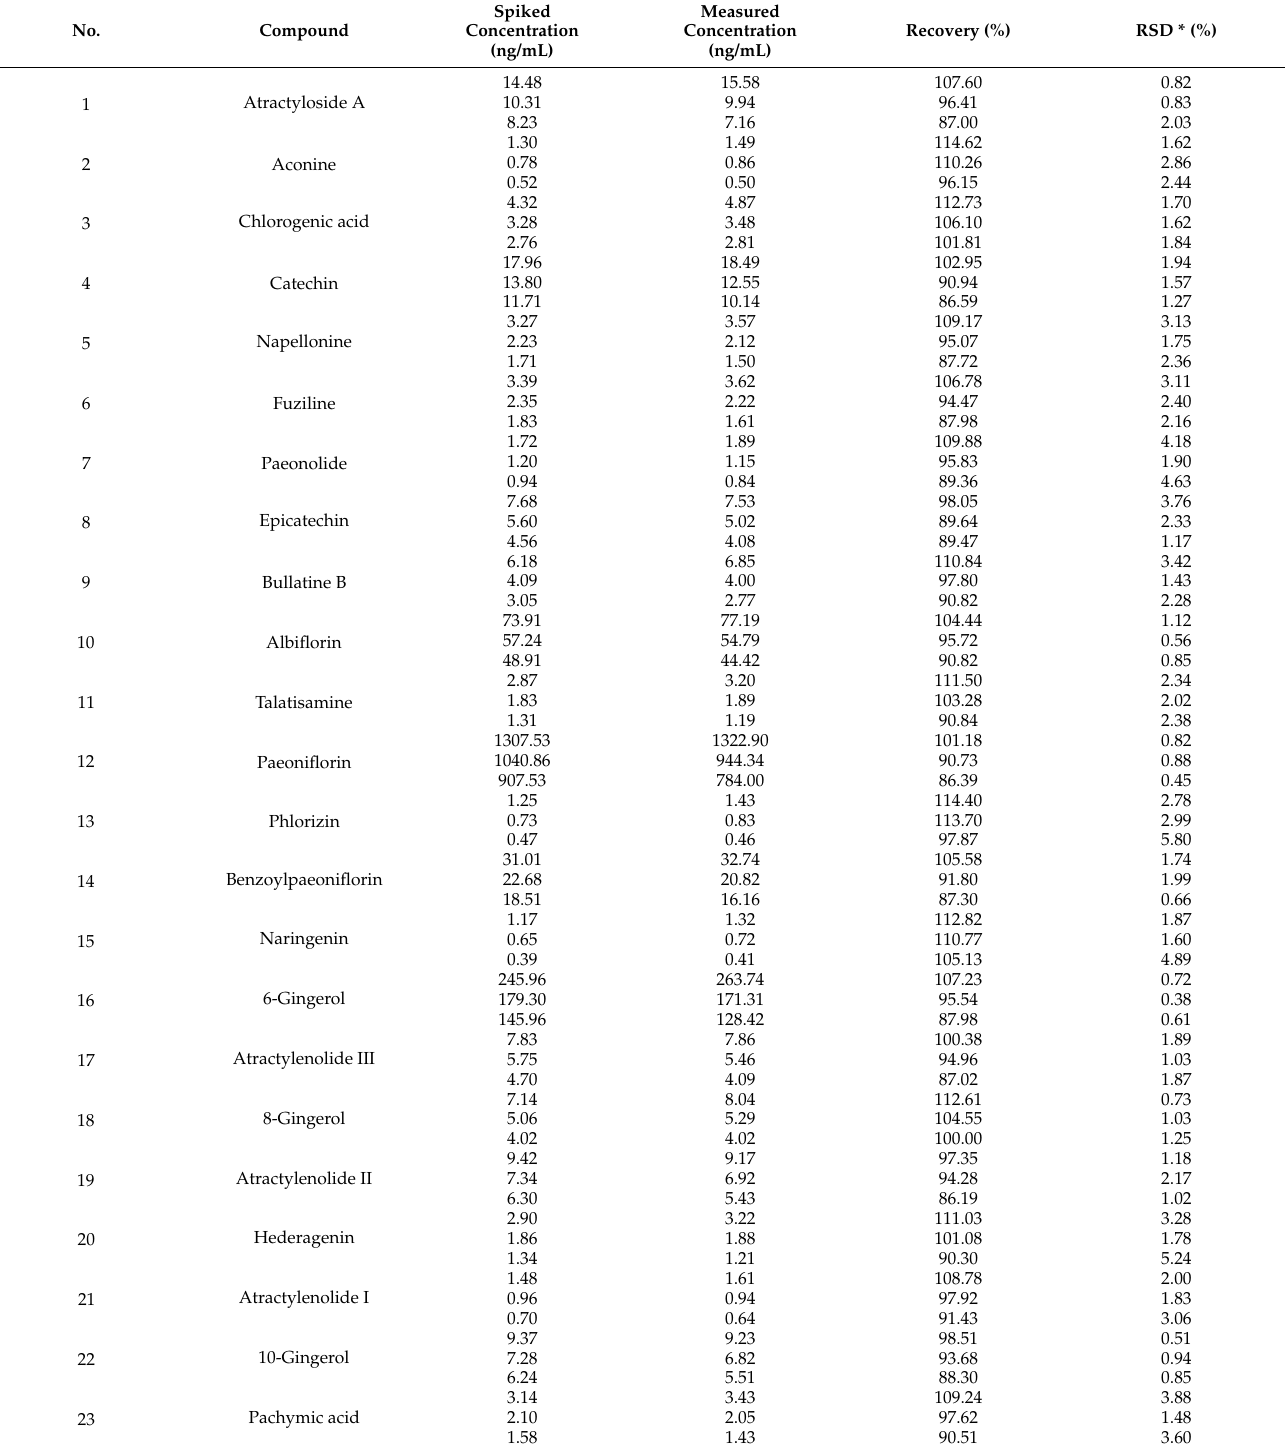
Table 3. Recovery test for the assay of the 23 compounds in